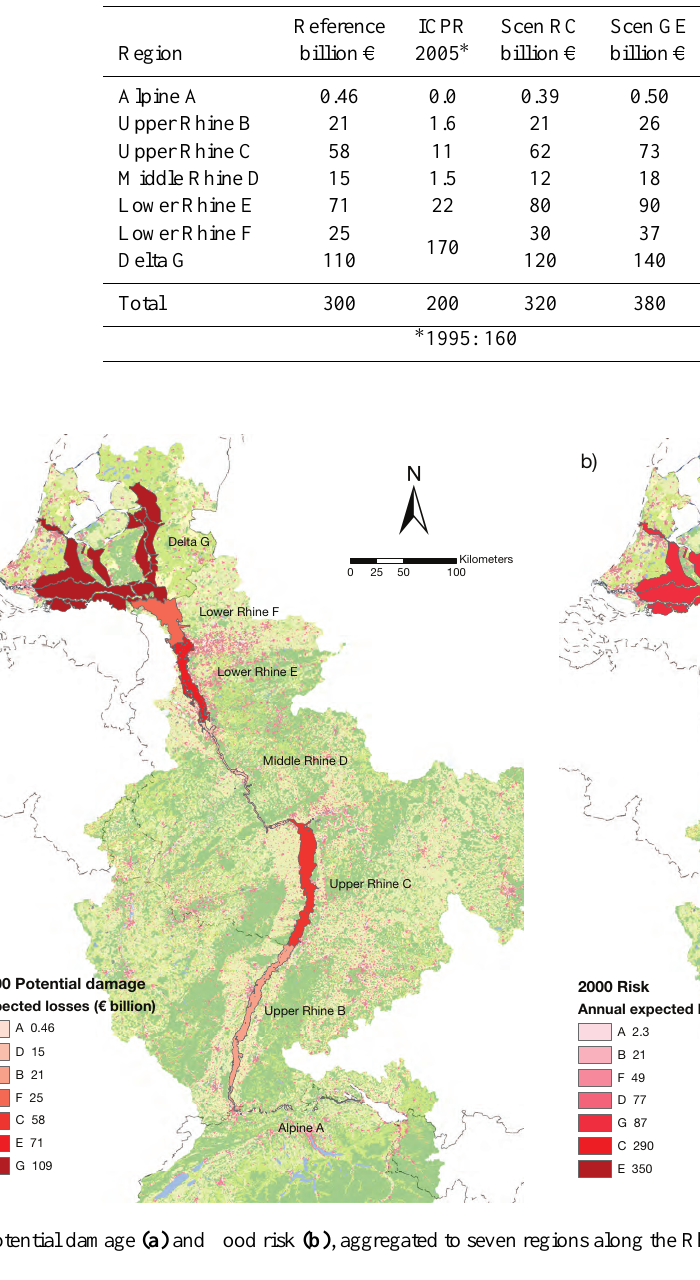
exception of the Lower Rhine region (F) (+18%). In some areas, such as the Middle Rhine, the RC scenario even projects a decrease in potential damage. The GE scenario gives an overall larger increase in potential damage (21%). Moreover, expected damage seems to increase substantially in almost all regions, often by more than 15% and ranging up to 34%.